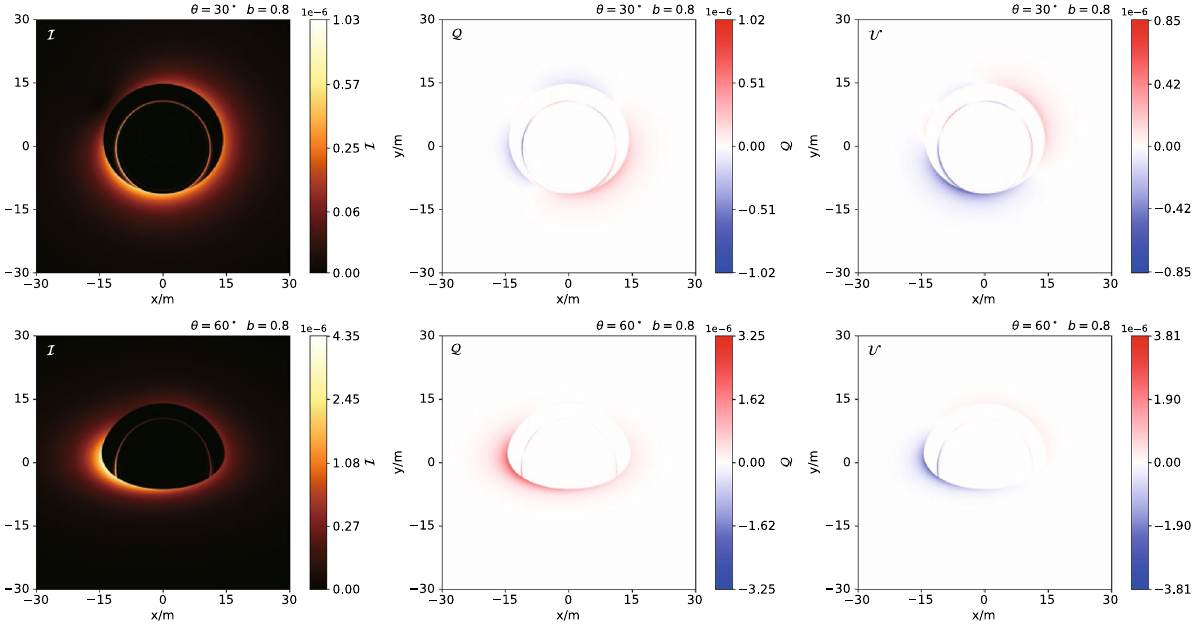
Fig. 9 Distribution of the Stokes parameters Q and U in the image of Bonnor black dihole with parameter b = 0 . 8. The panels in the top and bottom rows correspond to the cases with θ 0 = 30 ◦ and θ 0 = 60 ◦ ,